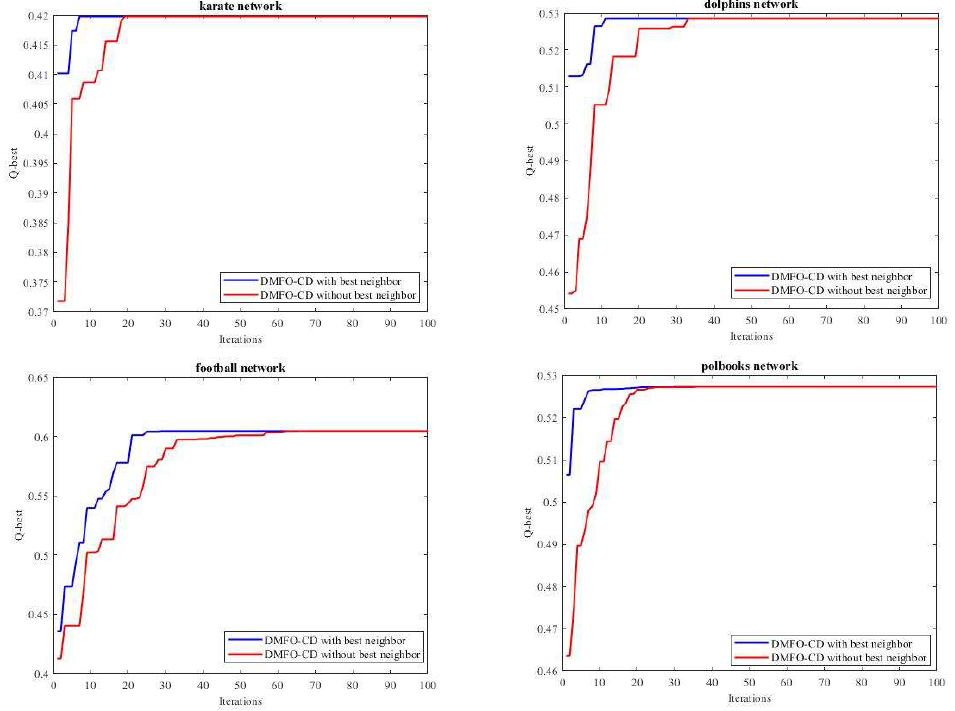
Figure 13. Impact of using the best neighbor on convergence speed of DMFO-CD.